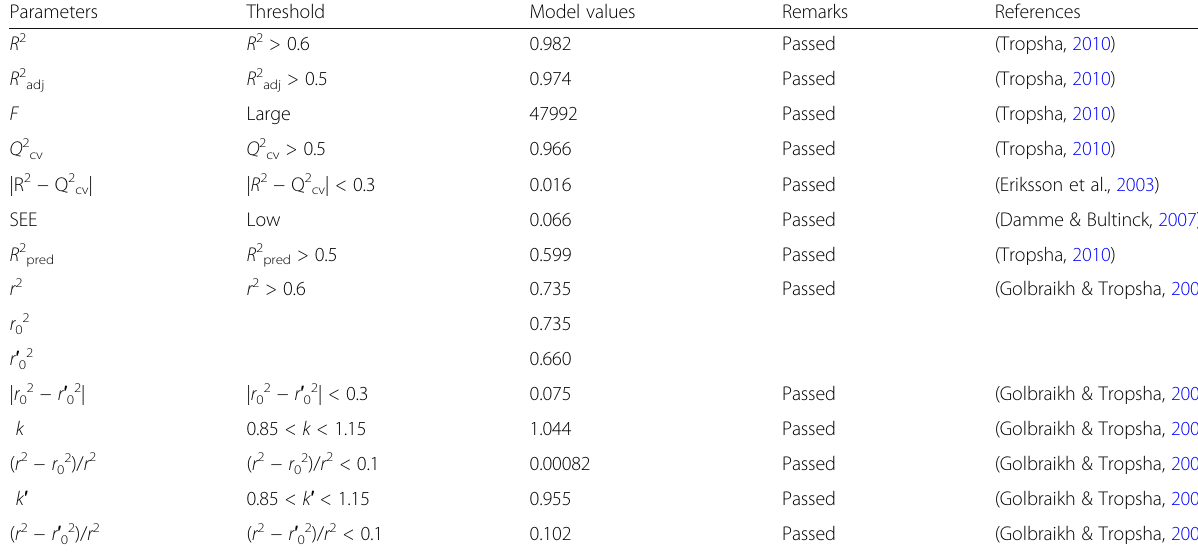
Table 2 Validation parameters of the model